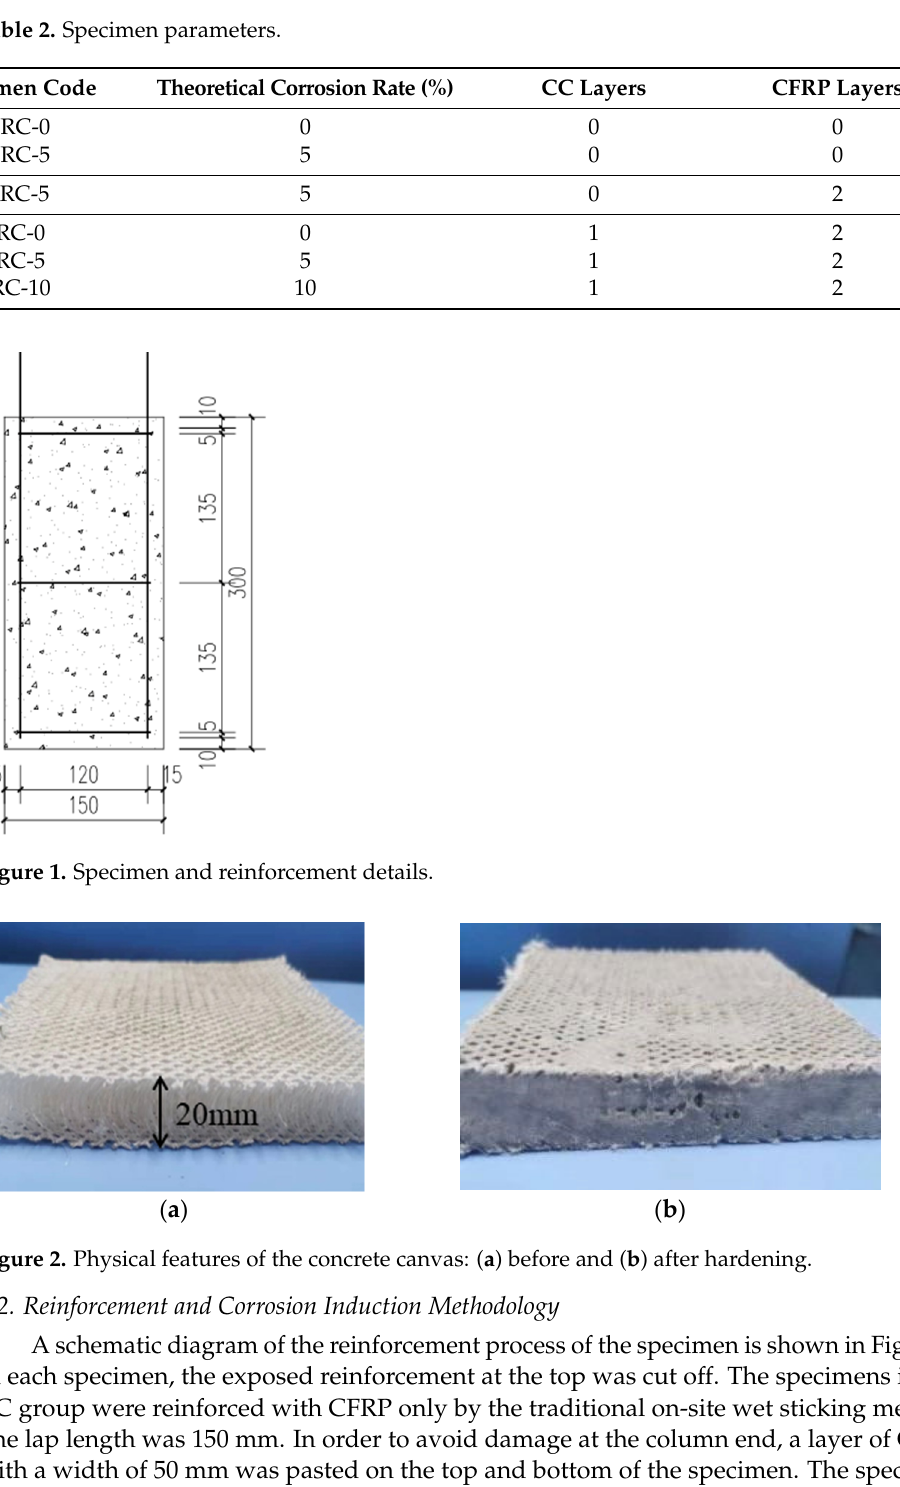
Figure 2. Physical features of the concrete canvas: ( a ) before and ( b ) after hardening.